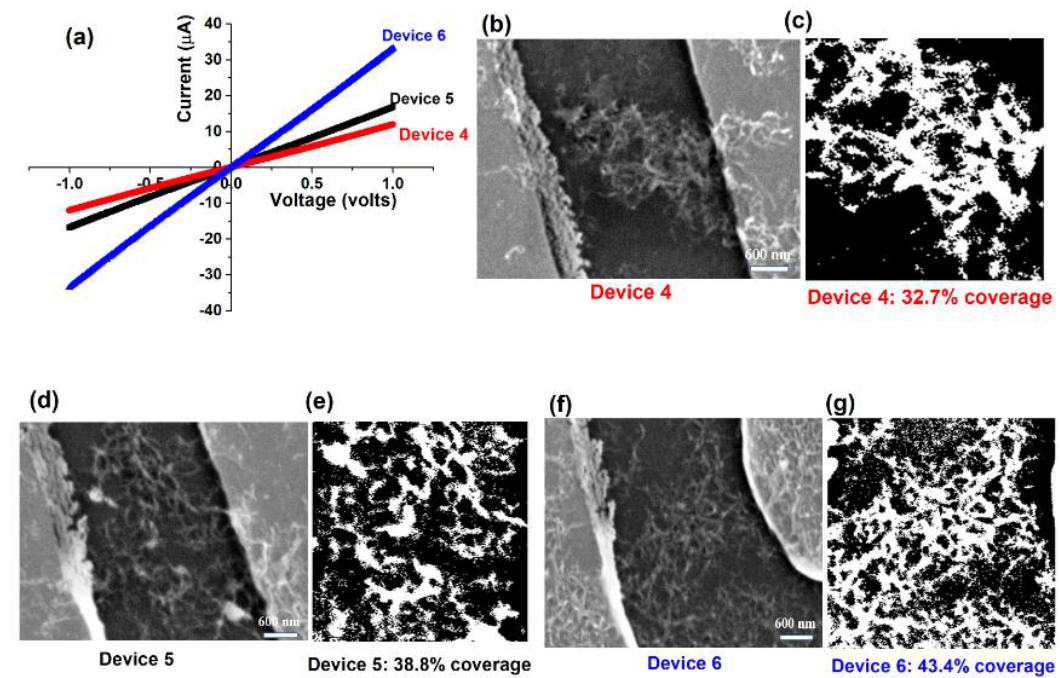
Figure 7. ( a ) Current-voltage characteristics for three CNT devices that have a significant number of interconnected MWCNTs in the network, ( b , c ) SEM image and corresponding binary image of device 4 showing interconnected CNTs in the channel, corresponding to an areal coverage of 32.7%, ( d , e ) SEM image and corresponding binary image of device 5 showing a higher density of interconnected CNTs in the channel, corresponding to an areal coverage of 30.8%, ( f , g ) SEM image and corresponding binary image of device 6 showing a very high density of interconnected CNTs in the channel, corresponding to an areal coverage of